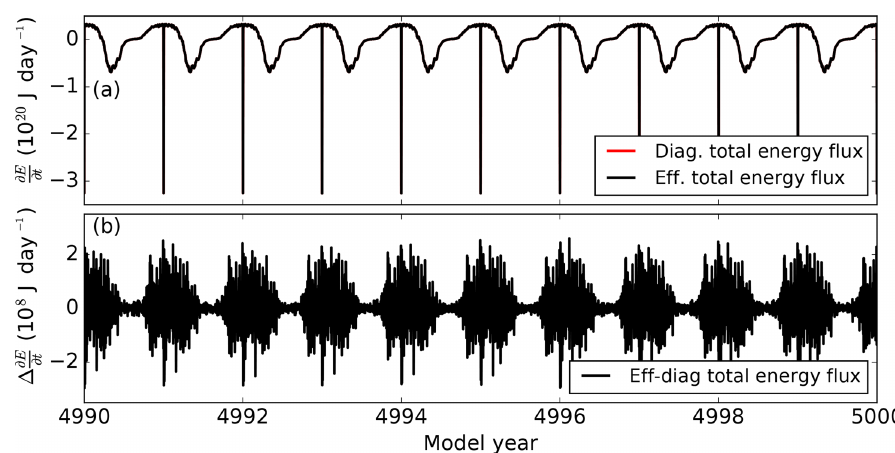
Figure 6. Total energy fluxes integrated over the entire model domain after 5000 model years. (a) Diagnosed and effective total energy flux, the former being covered by the latter. (b) Observed minus diagnosed total energy flux. Abrupt changes in the time series are due to energy (and mass) transfer to the ice sheet model (compare Fig. 5b).